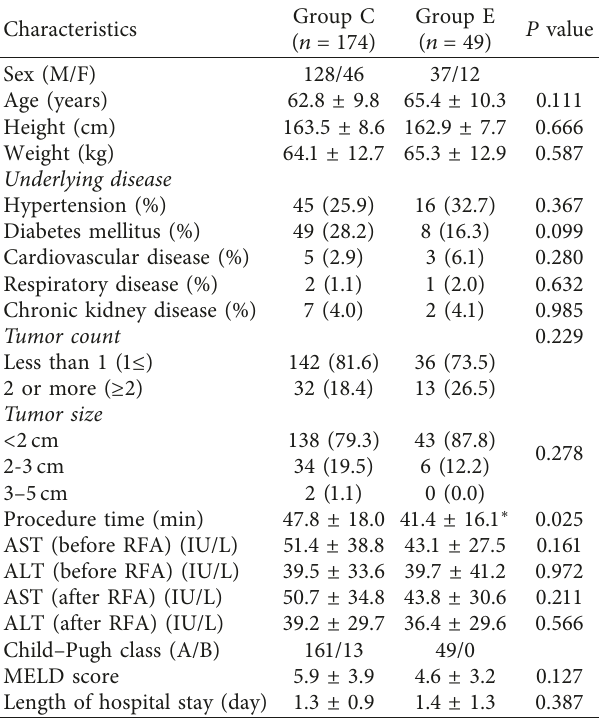
Table 1: Patient characteristics.